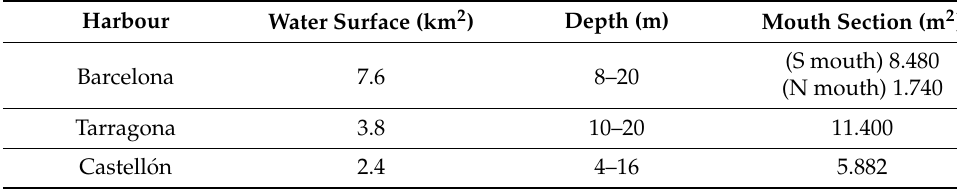
Table 1. Main geometrical characteristics of the studied harbour domains.